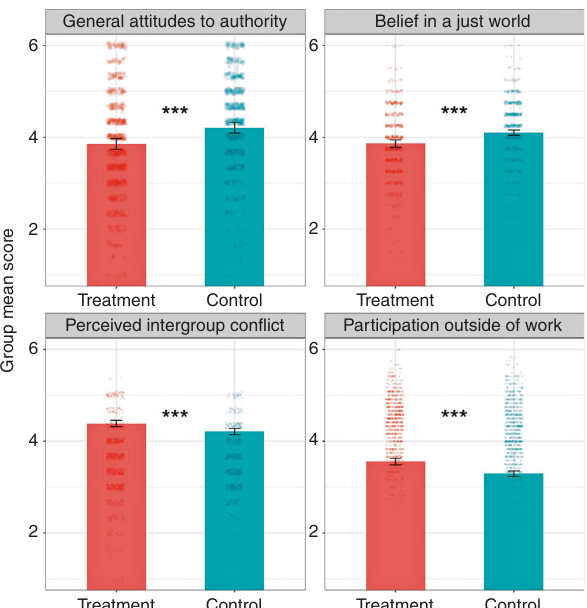
Fig. 1 Study 1 group mean ratings. Study 1 group mean ratings of general attitudes toward authority, belief in a just world, perceived intergroup con fl ict between managers and workers in the larger society, and participation outside of work, on a 6-point scale. Ratings are shown as a function of assignment to participatory meetings condition (treatment). Error bars show 95% con fi dence intervals. Linear regressions with fi xed effects included a dummy variable indicating treatment, and a vector of pre- treatment individual demographic covariates to improve ef fi ciency. Robust standard errors clustered by group accounted for residual covariance on the group level. Two-tailed p -values for the average treatment effect were all smaller than 0.001. Note: *** p < 0.001, ** p < 0.01, * p < 0.05.